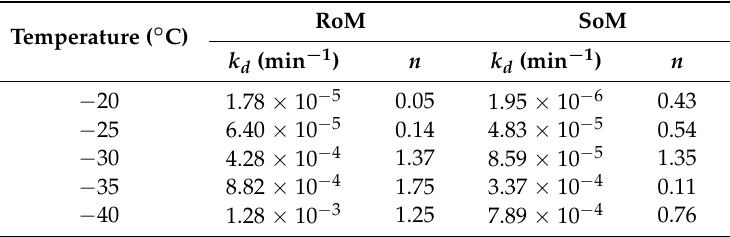
Table 4. Variation of destabilization kinetic parameters with freezing temperature for RoM and SoM.